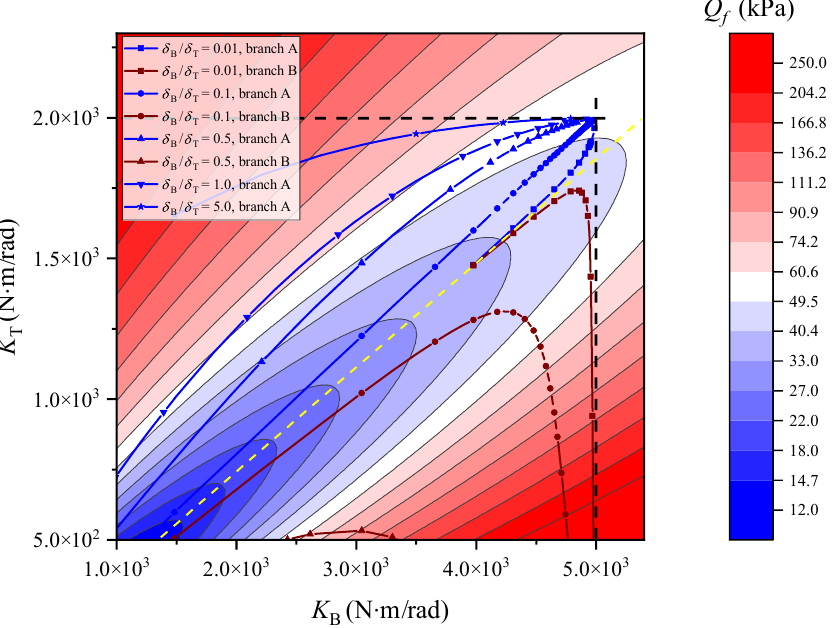
Figure 11. LCO solutions on linear flutter dynamic pressure nephogram ( K B = 5.0 × 10 3 N · m/rad, K T = 2.0 × 10 3 N ·